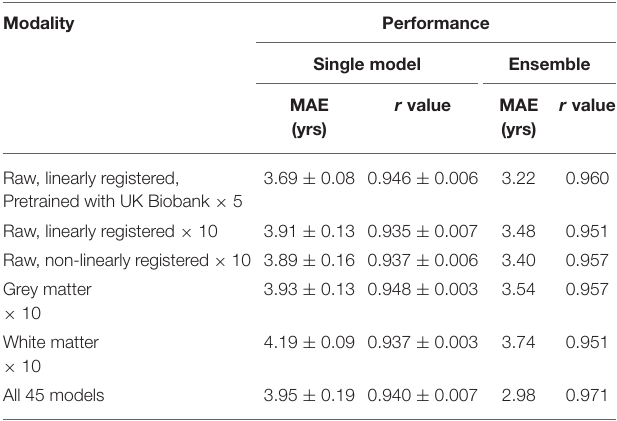
pseudo-modalities (outputs from distinct